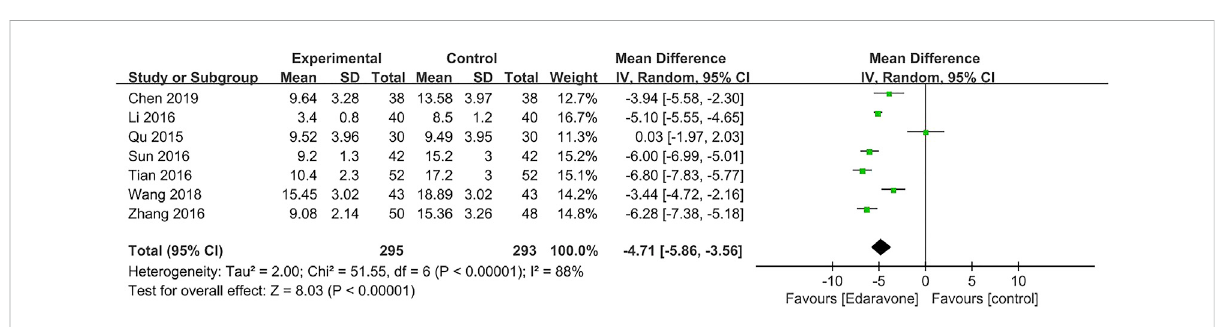
FIGURE 6 Forest plot for the effect of edaravone on hematoma